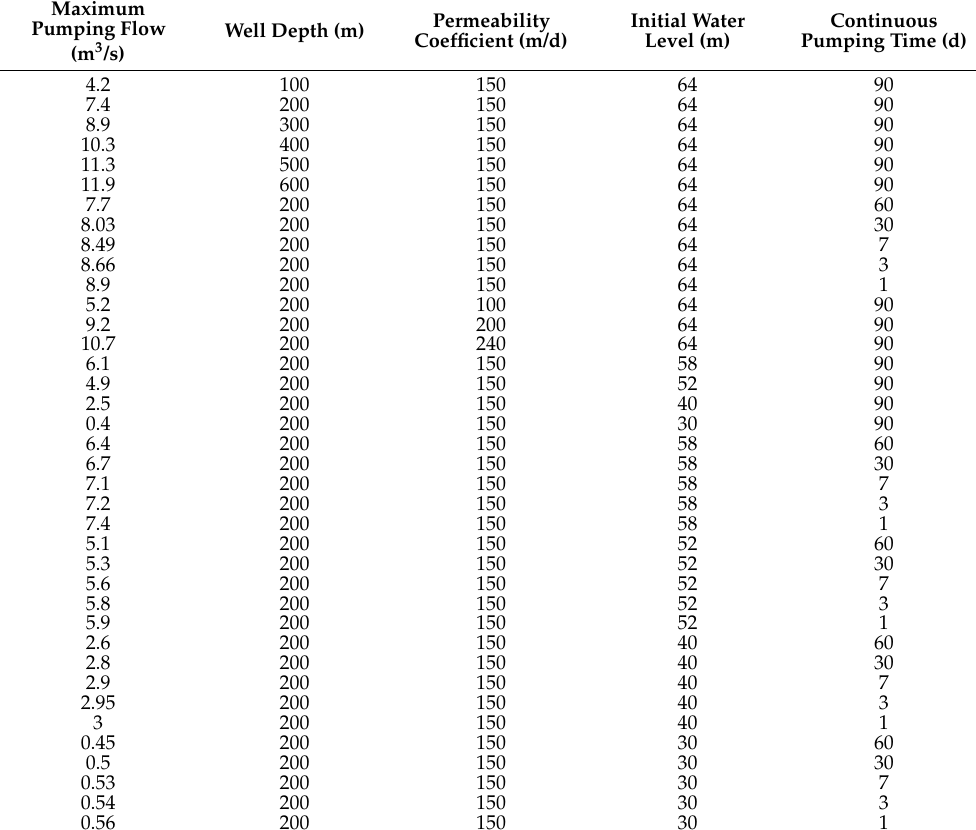
Table A1. Maximum pumping flow of different working conditions.